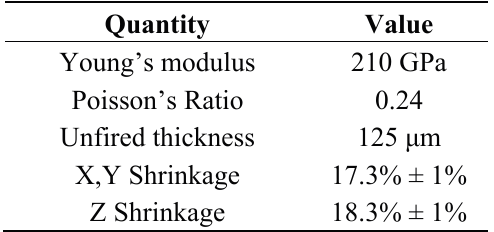
Table 1. Characteristics of the zirconia ceramic.